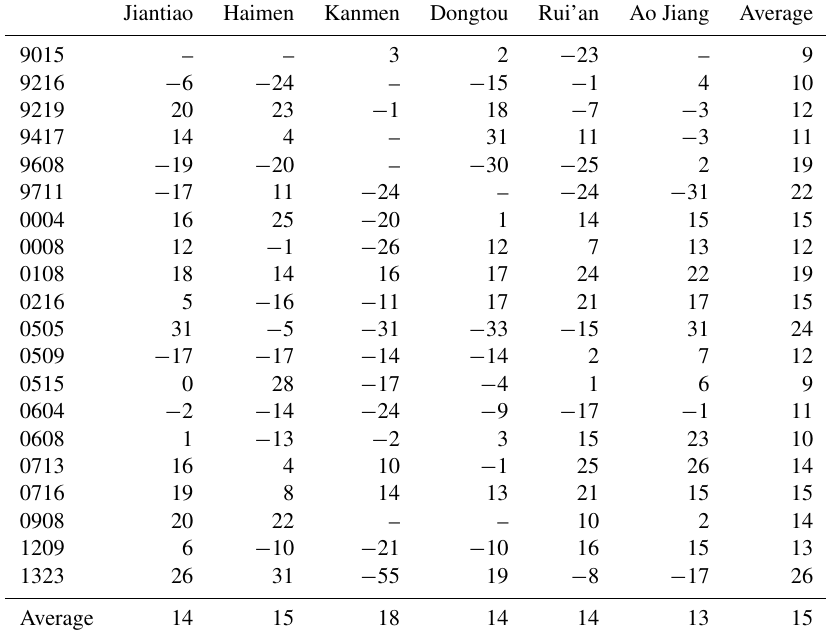
Figure 7. (a) Simulated inundated area and (b) surveyed inundated area during Typhoon Fitow. Table 2. Error statistics in terms of maximum water level during landfall of 20 typical typhoons (unit – cm).